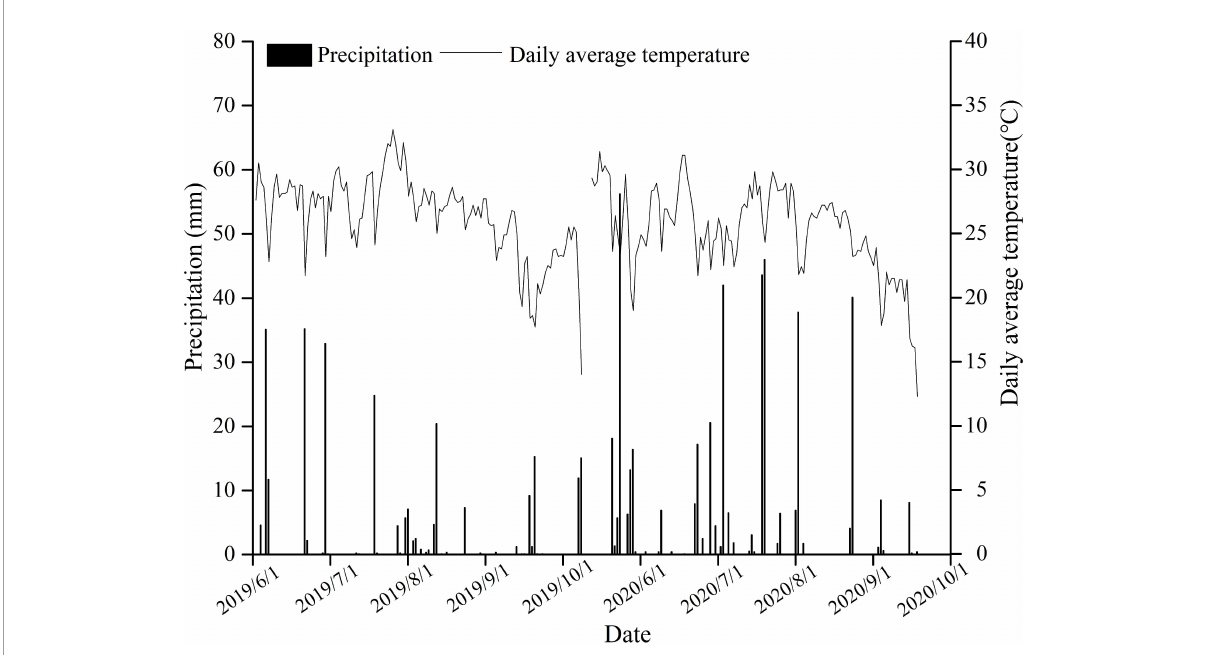
FIGURE1 Temperature and precipitation measurements during the maize-growing